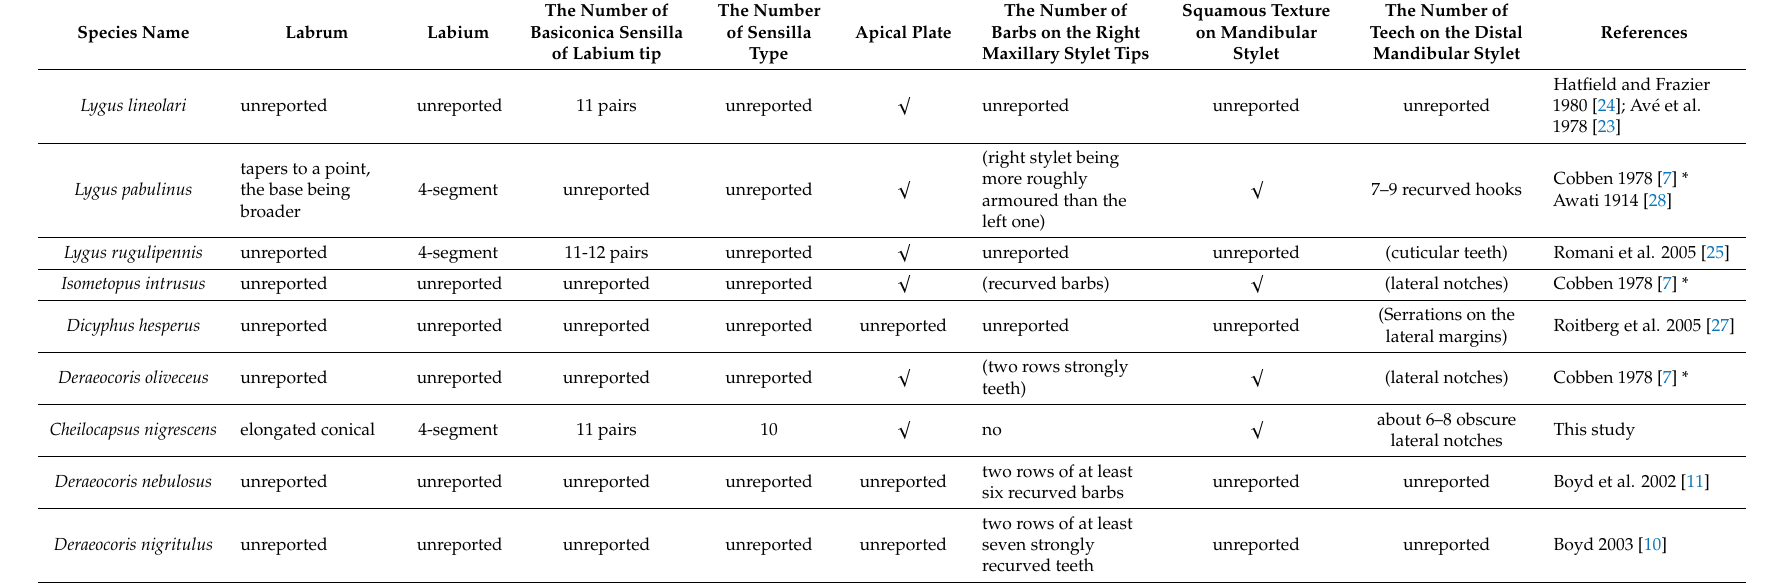
Table 3. Main features of mouthparts of Miridae. * Characters in parentheses were summarized from figures in Cobben 1978